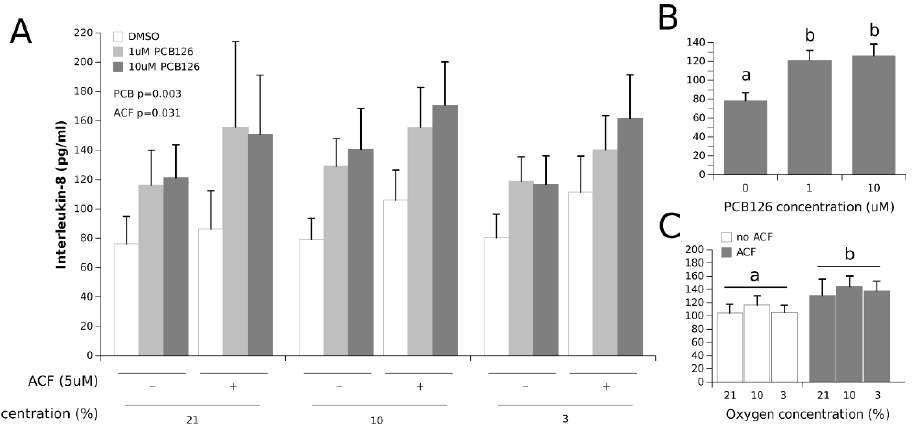
Figure 6. Effect of PCB126 and hypoxia on the media IL-8 concentration in human adipocytes. Adipocytes were treated with DMSO (vector) or 1 and 10 µ M PCB126 for 24 h, then subjected to 21, 10 or 3% O 2 for another 24 h. Acriflavine (ACF) 5 µ M was used as an HIF1 α -inhibitor. Panel ( A ) illustrates the whole model. Markers of statistical difference for individual bars were omitted due to the complexity of the model. Panel ( B ) summarizes the main effect of PCB126 on media IL-8 concentrations. Panel ( C ) summarizes the effects of hypoxia and ACF treatment on media IL-8 concentrations. In panels B and C, bars or groups of bars not sharing a common letter are statistically different at p < 0.05. Each bar represents the mean ± SEM of three separate experiments for each treatment